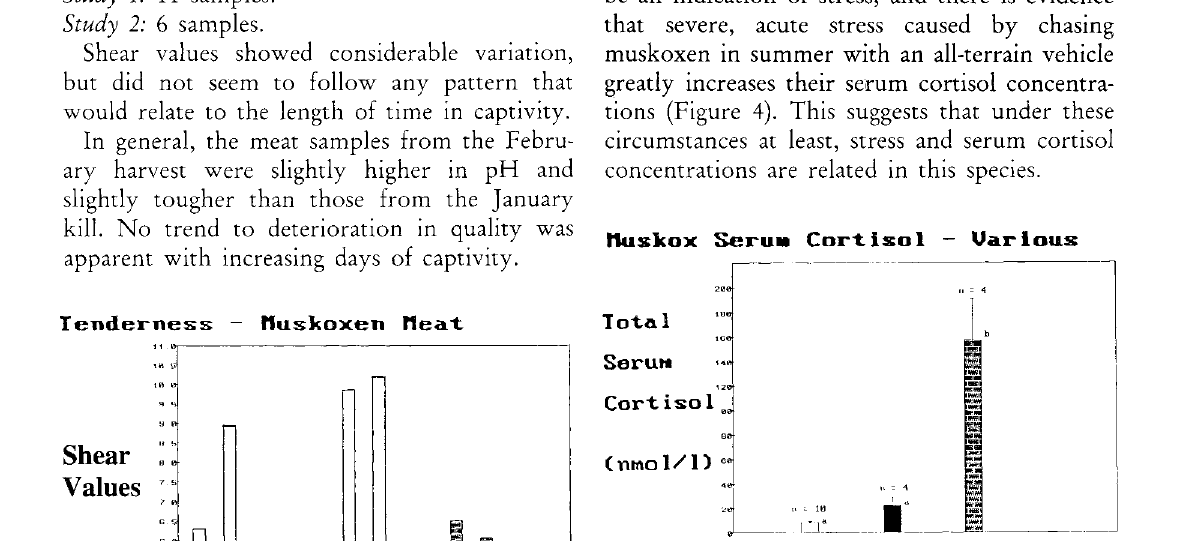
Fig. 3. Shear values (toughness) of meat from musk- oxen slaughtered in January/91 and Febru ary/91.